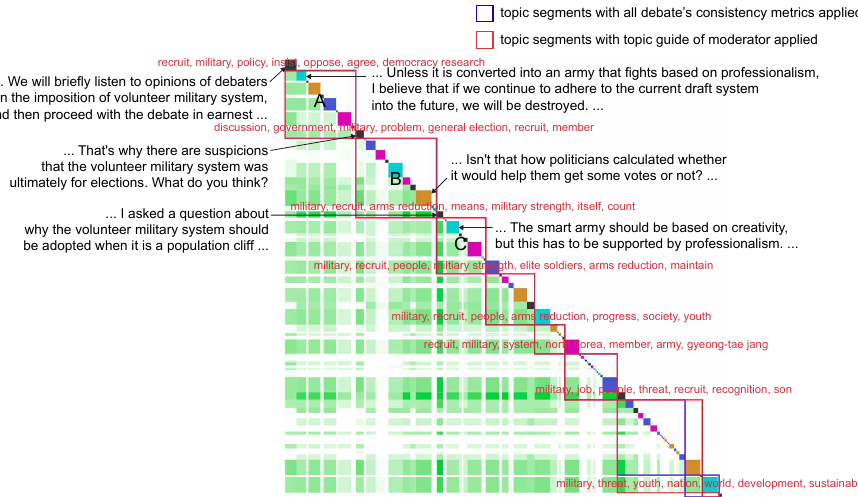
Figure 31. Comparison of a case where weight of “topic guide of moderator” was applied and a case where all weights of debate consistency metrics were applied. Red squares are topic segments when weighted only by “topic guide of moderator”, and blue squares are topic segments of a result weighted by all debate consistency